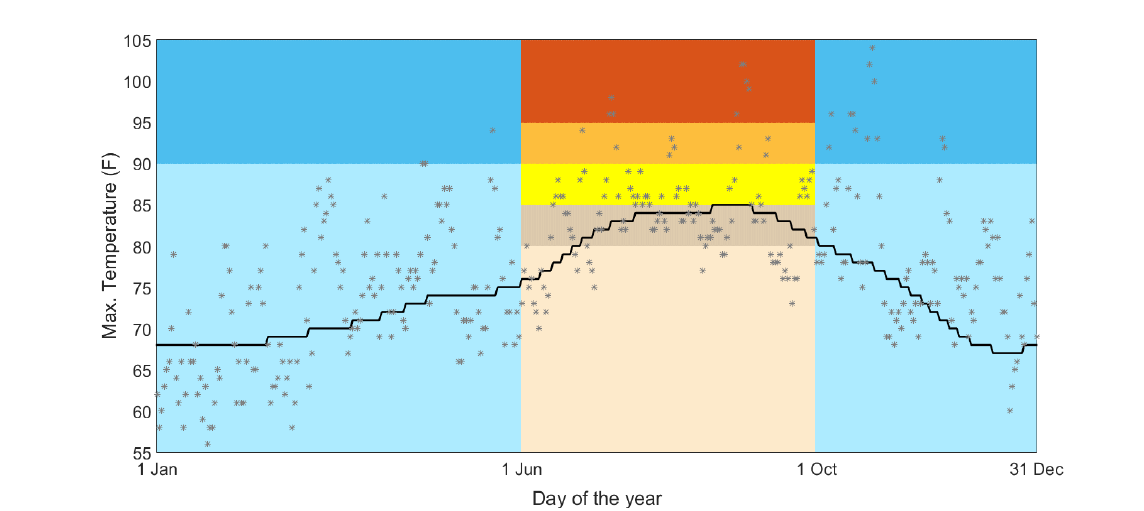
Figure 6. 2017 temperature (*) vs. Average temperature (line) in Los Angeles, CA [30]. Each background color implies a different daily tariff. Only seasonal and temperature effects on tariff are considered.